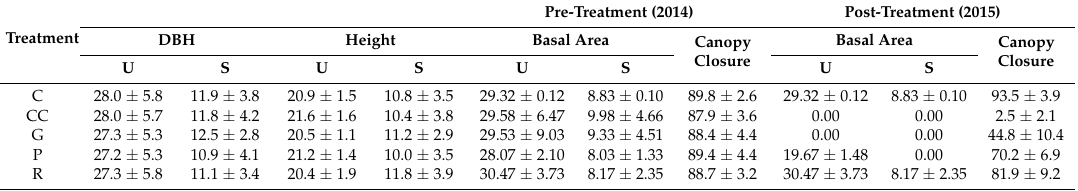
Table 1. Characteristics of forest structure around the plots, before and after treatments. Structural attributes (mean ± standard deviation) presented here are the diameter at breast height ([DBH], cm), canopy height (m), basal area (m 2 ha − 1 ), and canopy closure (%). U—upper layer; S—sub-canopy layer; C—control; CC—clear-cutting; G—gap-cutting; P—preparation cutting; R—retention tree group. The mean and standard deviation were calculated based on the six replicates for each treatment type. Pre-Treatment (2014) Post-Treatment (2015) Treatment DBH Height Basal Area Canopy Basal Area Canopy ClosureU Closure